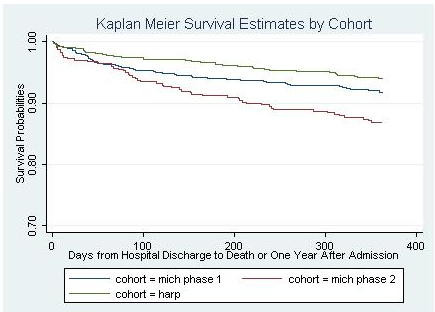
Unadjusted Survival Curves Comparing Three Patient Cohorts from the Same Hospitals Starting with Hospital Discharge to One Year After Hospital Admission.